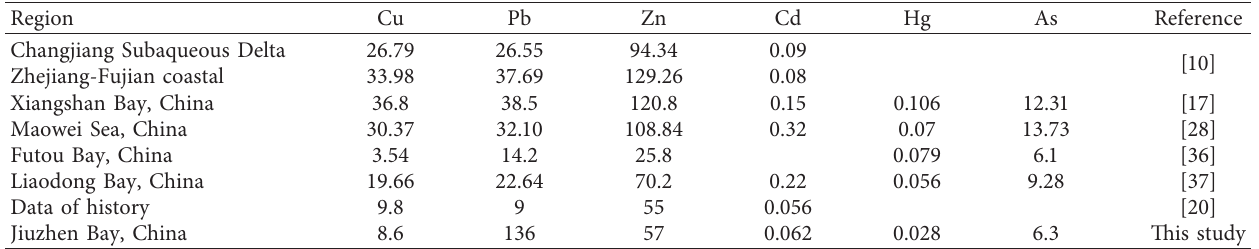
Table 8: Concentrations of heavy metals in sediments ( µ g/g dw) in the present study compared to published data from other locations in China. Region Cu Pb Zn Cd Hg